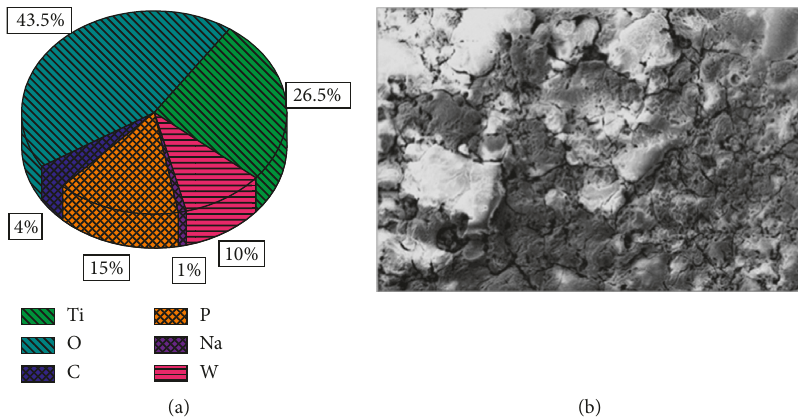
x · WO y oxide PEO coatings, obtained at different 2000. ×